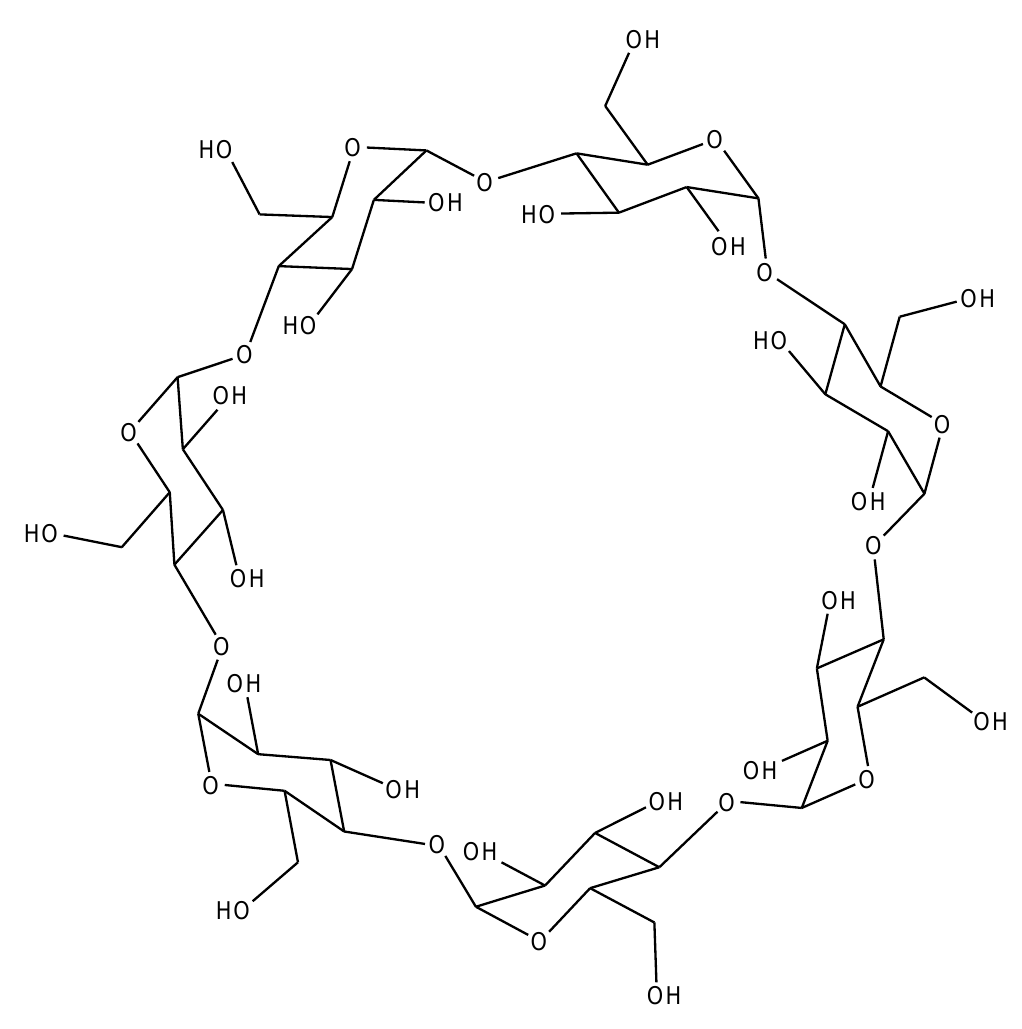
Figure 1. The structure of β-cyclodextrin